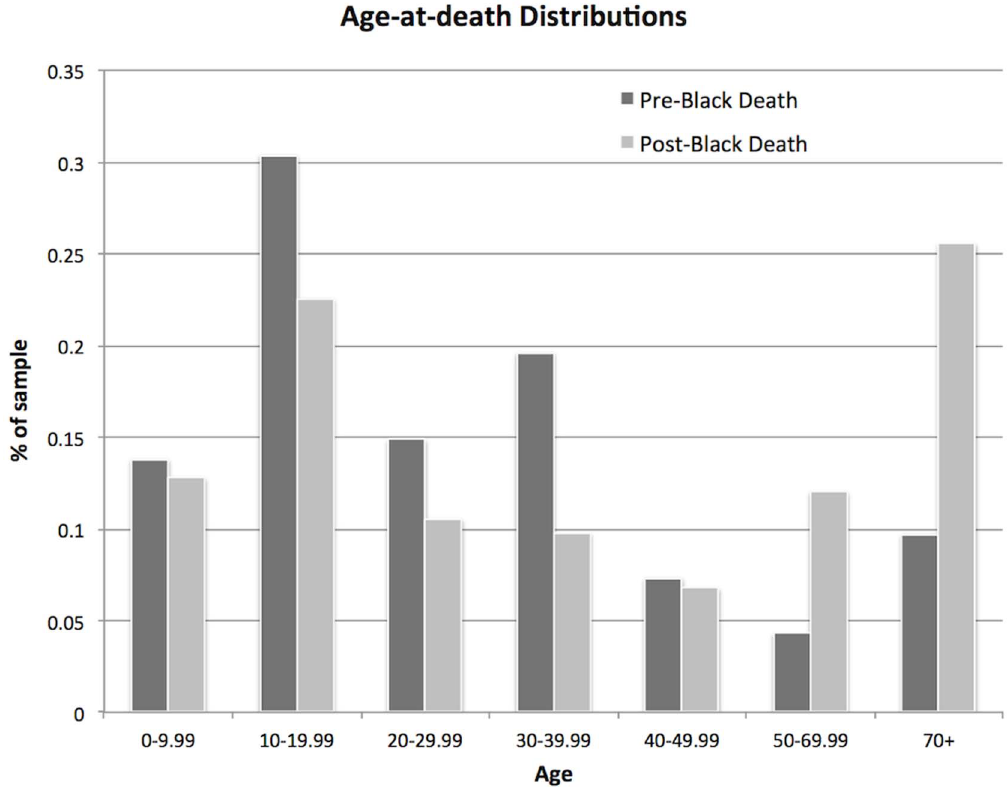
Figure 1. Age-at-death distributions for the pre- and post-Black Death samples.